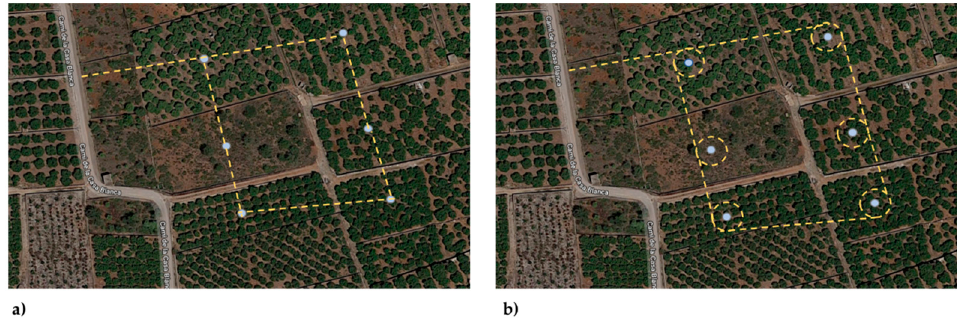
Figure 1. ( a ) Flight plan with straight lines, ( b ) Flight plan circling the nodes.